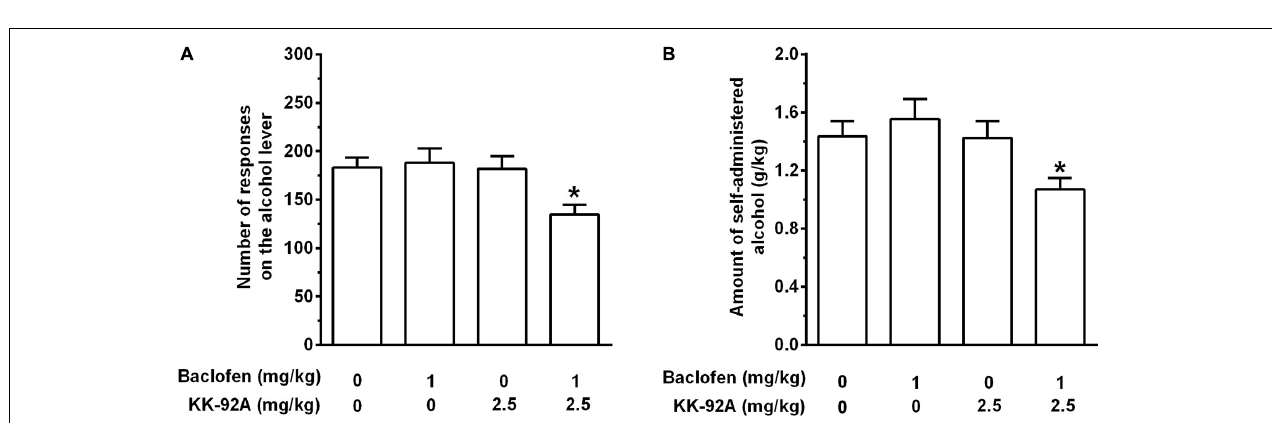
FIGURE 3 | Effect of acute treatment with the combination of per se ineffective doses of the positive allosteric modulator of the GABA B receptor, KK-92A, and the GABA B receptor agonist, baclofen, on number of lever-responses for alcohol (A) and amount of self-administered alcohol (B) in female Sardinian alcohol-preferring rats. Rats were initially trained to lever-respond for oral alcohol (15% v/v in water) [Fixed Ratio (FR) 5 (FR5)] and water (FR1) in daily 30-min self-administration sessions. Once lever-responding had stabilized, rats were tested with all treatment combinations under the same FR schedule of reinforcement. KK-92A and baclofen were administered intraperitoneally 30 min before the start of the self-administration session. Each bar is the mean ± SEM of n = 12 rats. * P < 0.05 in comparison to all other rat groups (Tukey’s